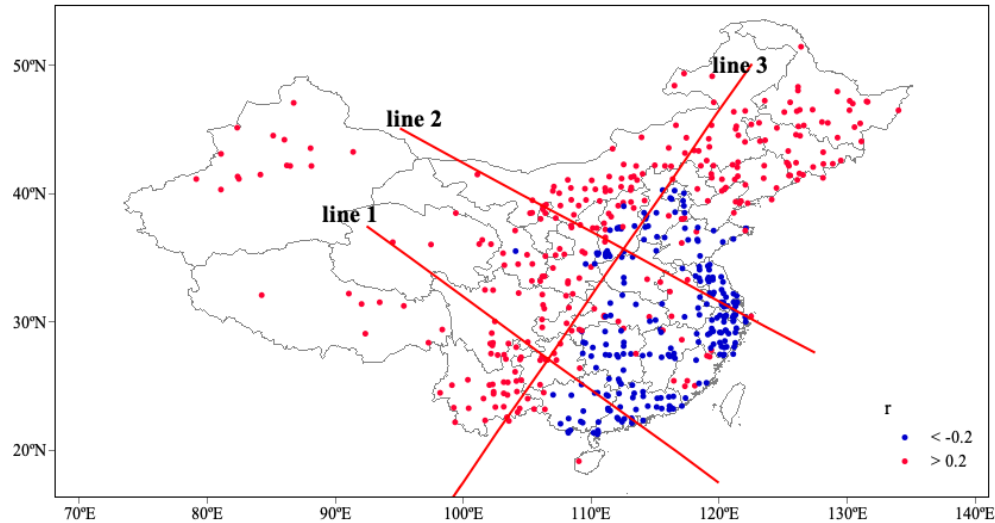
Figure 11. Spatial correlation distributions and profile diagram between the apparent heat source Q 1 on Qinghai-Tibet plateau and the haze days in China.